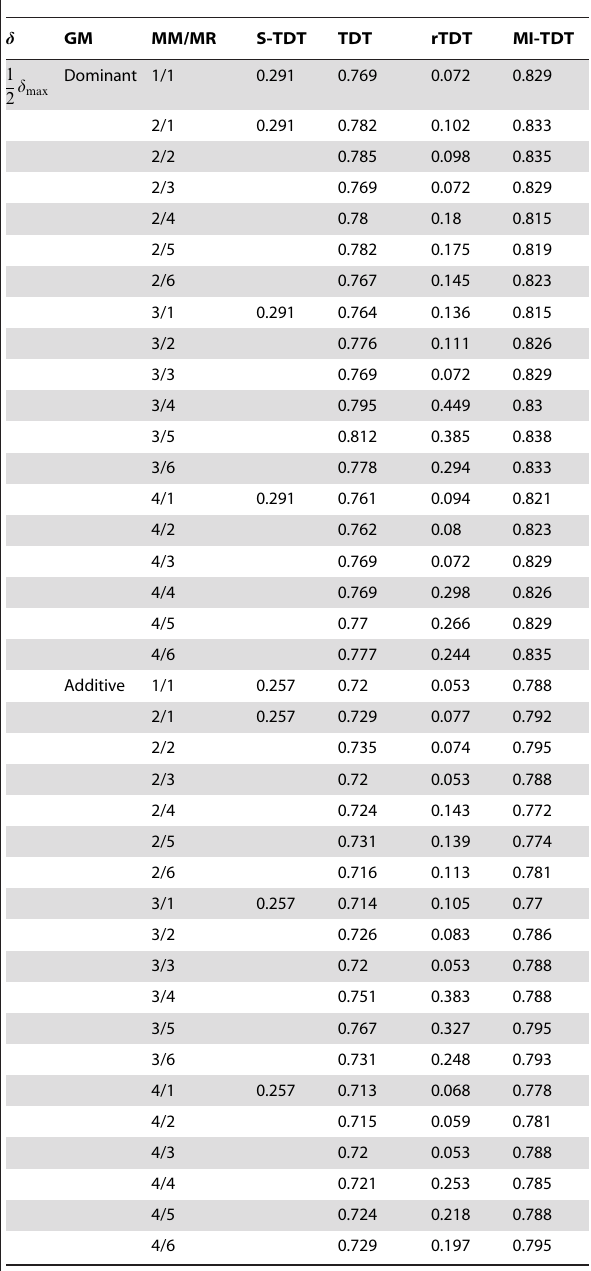
Table 9. Type I error rates at 5% significance level under the null hypothesis of h ~ 0 : 5 .